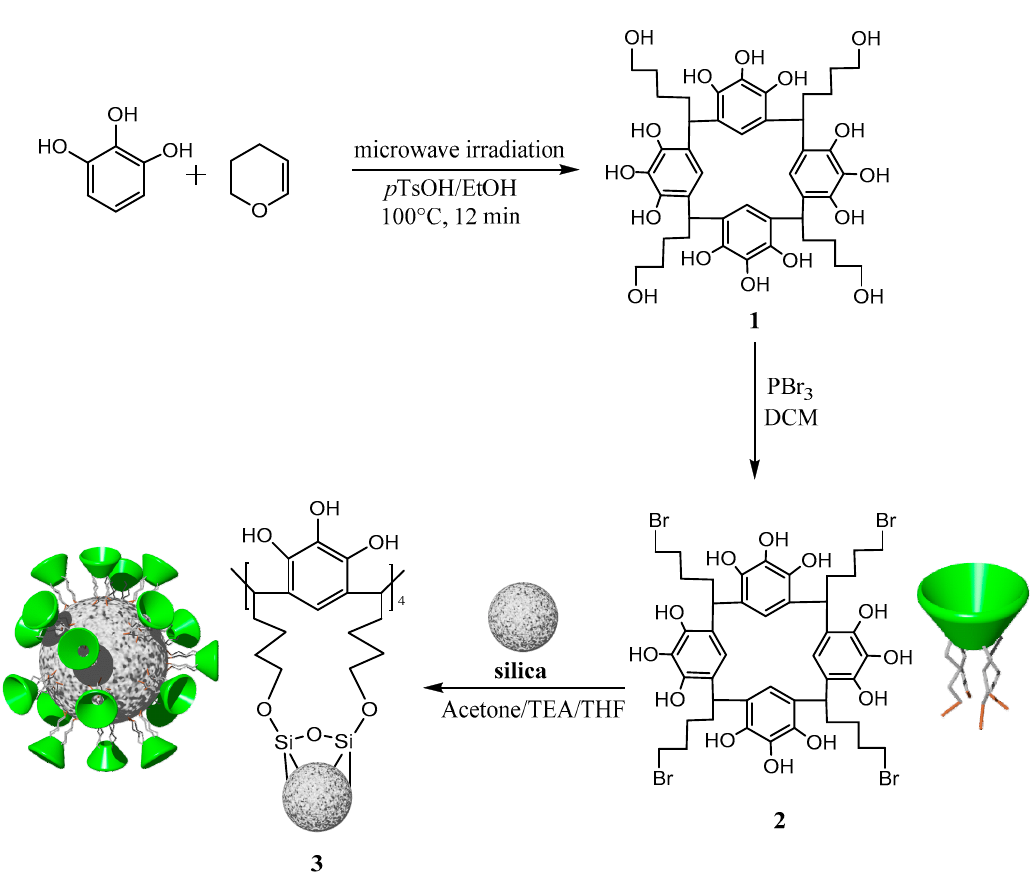
Figure 1. 1 H NMR spectrum (400 MHz, d 6 -DMSO, room temperature) of C -bromobutylpyrogallol[4]arene 2 .